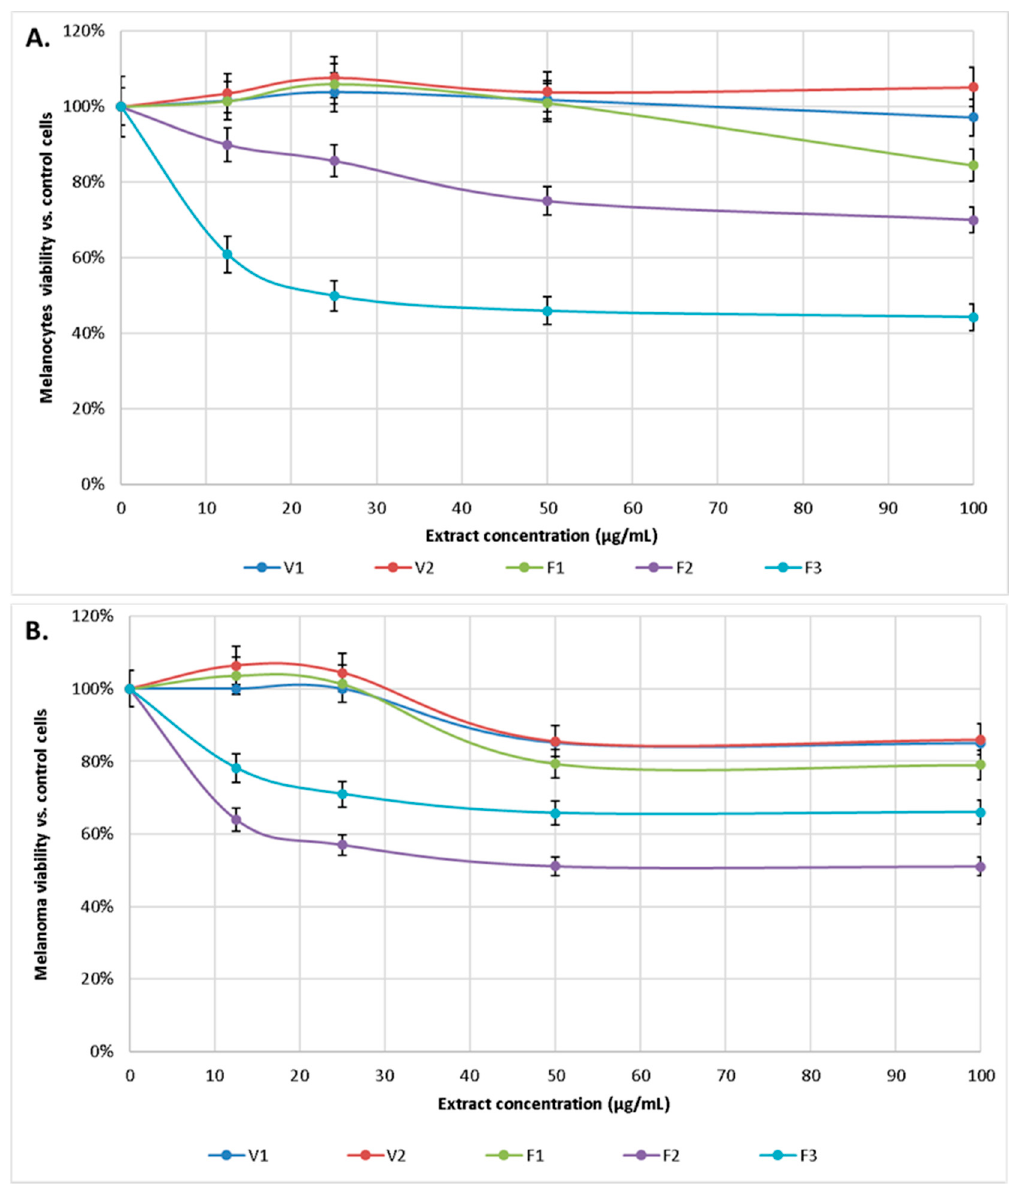
Figure 5. Effect of extract of S. hortensis L. (concentration range 12.5–100 µg/mL) on melanocytes ( A ) and melanoma ( B ) viability. Mean values ± SD of three independent experiments are pre- sented.